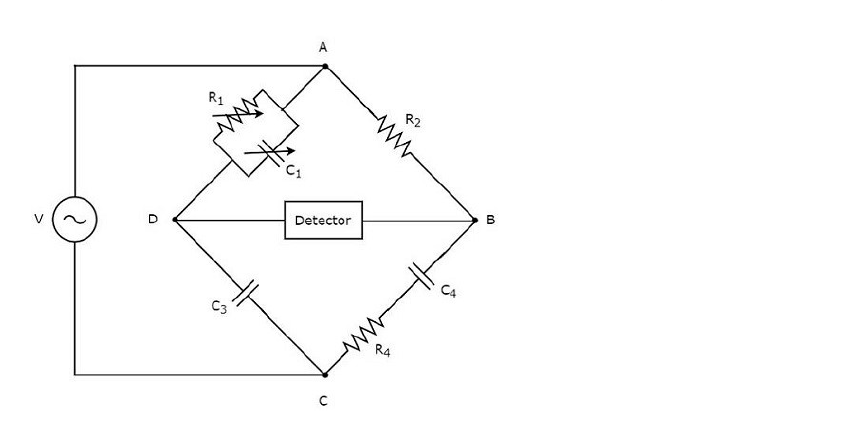
Figure 9. Connection configuration when using an LCR meter as a capacitance bridge to test the capacitance of a device under test (DUT). For the calculations of the dielectric constant, a thin unpolished sample of PMN-PT (approximately 12 mm × 10 mm × 0.5 mm) was characterized using a capacitance bridge apparatus. Capacitance values of the PMN-PT sample at multiple temperatures were com- pared to “open-cell” capacitance to determine the dielectric constant as a function of tem- perature. The PMN-PT samples for dielectric measurement require uniformity but can be un- polished. Beginning with one of the thin slices taken from the bulk sample segment, the pointed ends were removed. Additionally, it was necessary to remove the outer edge of the sample due to poor homogeneity in this area which is a result of the hot-press manu- facturing process. Following the sample shaping, conductive silver paint was applied to the two parallel faces to serve as electrodes for impedance measurements (Figure 10).